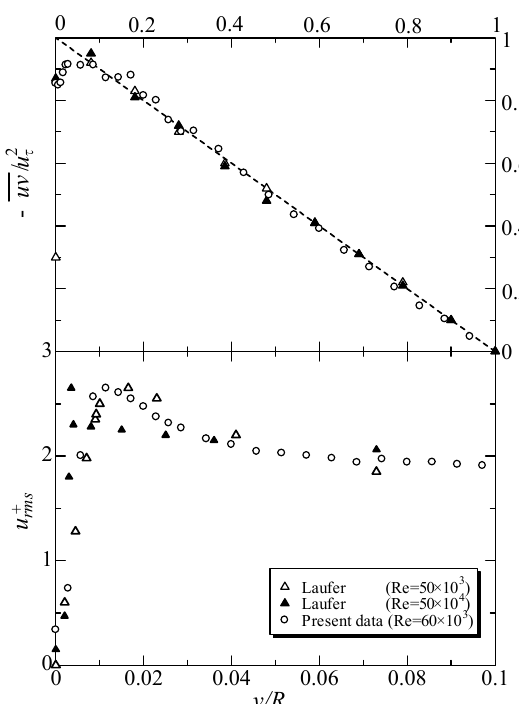
Fig. 2 Normalized turbulent intensities and Reynolds shear stress with friction